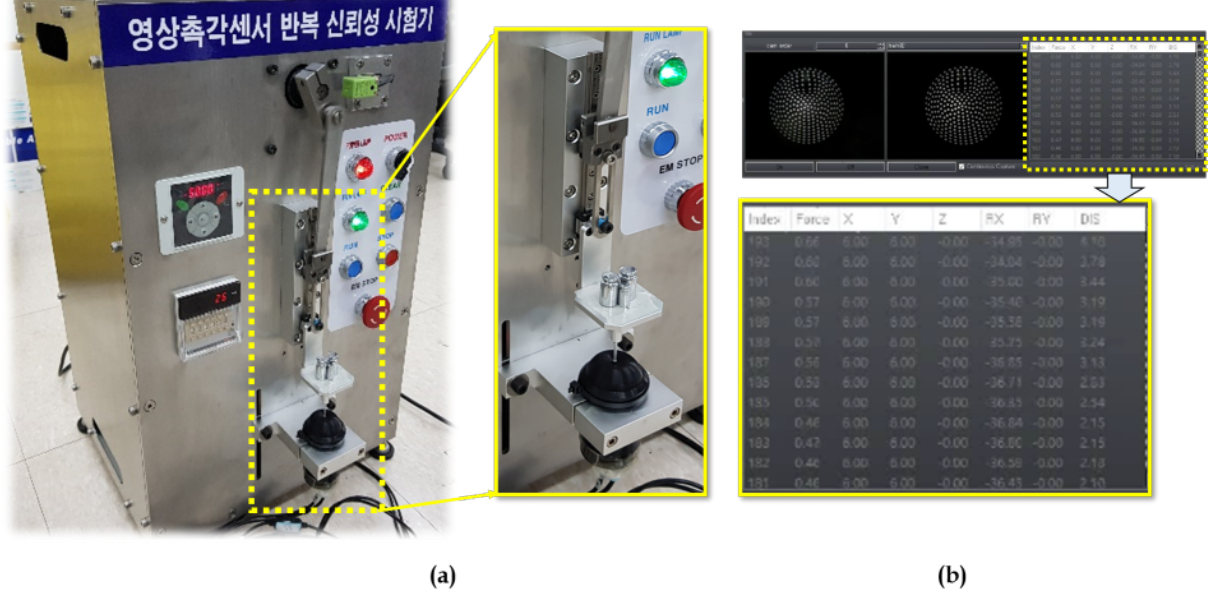
Figure 12. Data acquisition procedure for training and testing scenarios: ( a ) Instrument to conduct experiments. ( b ) Lab- VIEW GUI for collecting data under various motions ( X , Y , Z , R x , R y